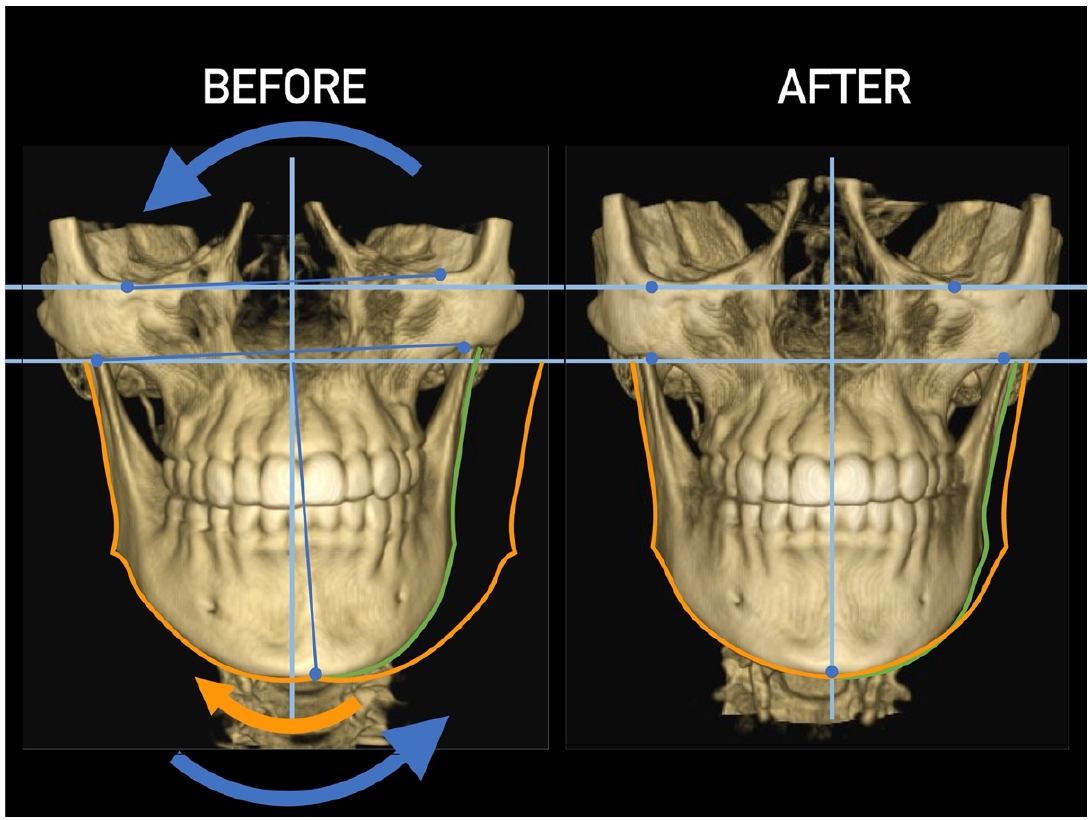
Figure 25. Effect of cervical vertebrae alignment. Anterior view.